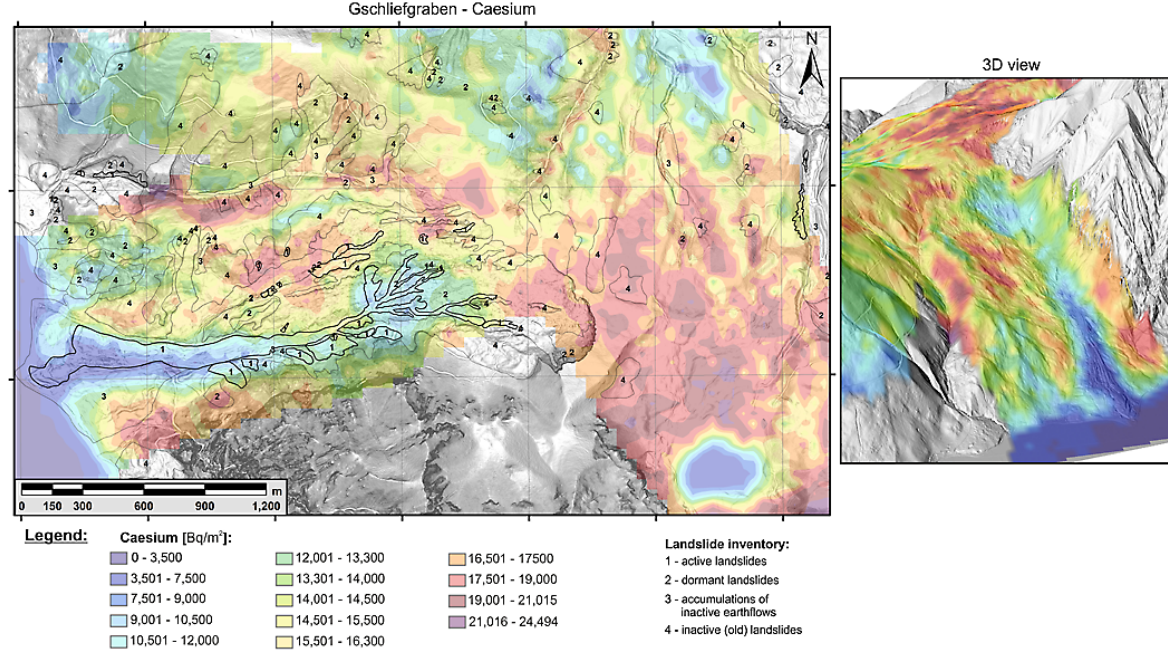
Fig. 13. Map of the Cs activity compared to the landslide inventory map; right side: 3-D view from the west.